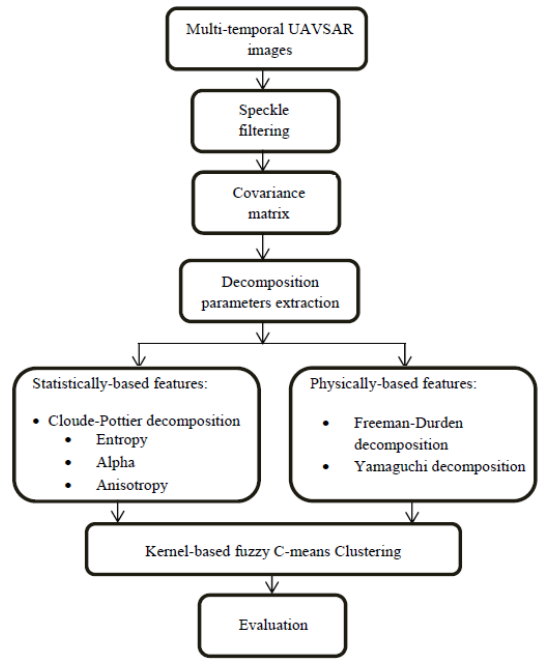
Figure 1 . An overview of the proposed method